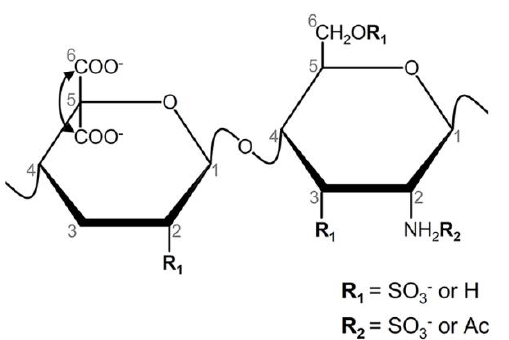
Figure 1. Structure of heparin. This glycosaminoglycan contains alternating units of 2–sulfated α -iduronic acid and N ,6–disulfated α –glucosamine with several minor modifications (R 1 and R 2 ). We highlight the occurrence of N –acetylated α -glucosamine and residues of non-sulfated α -iduronic acid or substituted with β –glucuronic acid. Minor units of N ,3,6–trisulfated α -glucosamine have an impact on the anticoagulant activity. Protons/carbons are enumerated on the pyranose rings and C6.